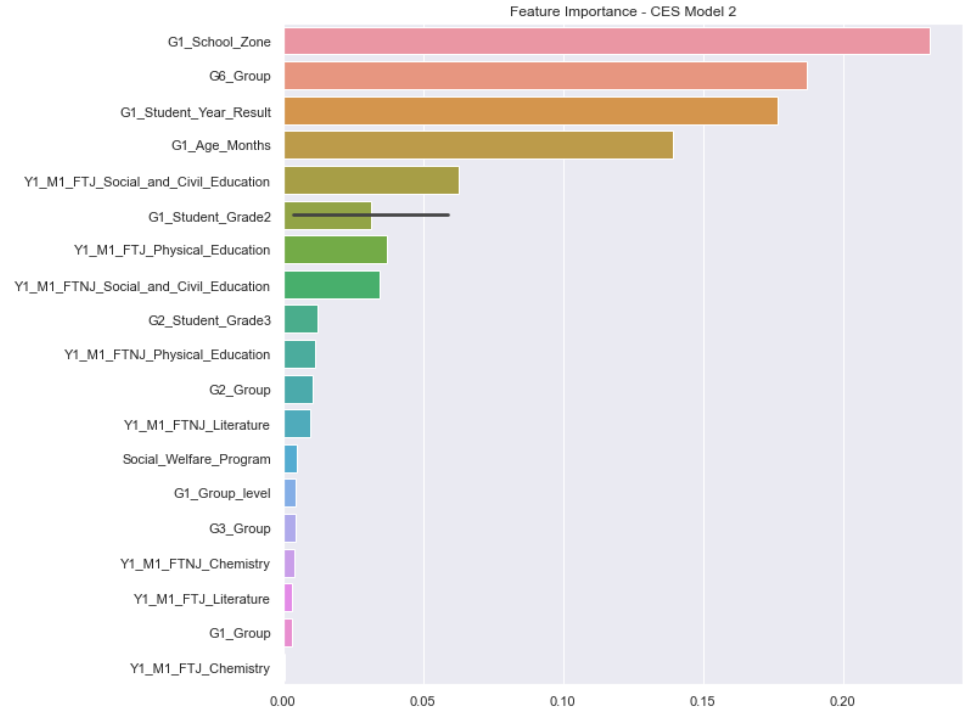
Figure 9. Feature importance for M2G1-CES. FTJ stands for justified absences, and FTNJ stands for non-justified absences. For instance, Y1_M1_FTNJ_Literature means the number of unjustified absences in Literature until Meeting 1 during Year 1 (grade 1). Group stands for the classification of the student performance according to the quartile of the performances of all students at that